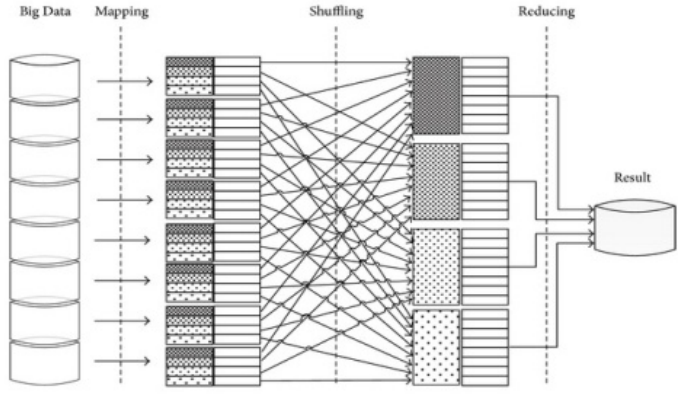
Figure 4. MapReduce architecture